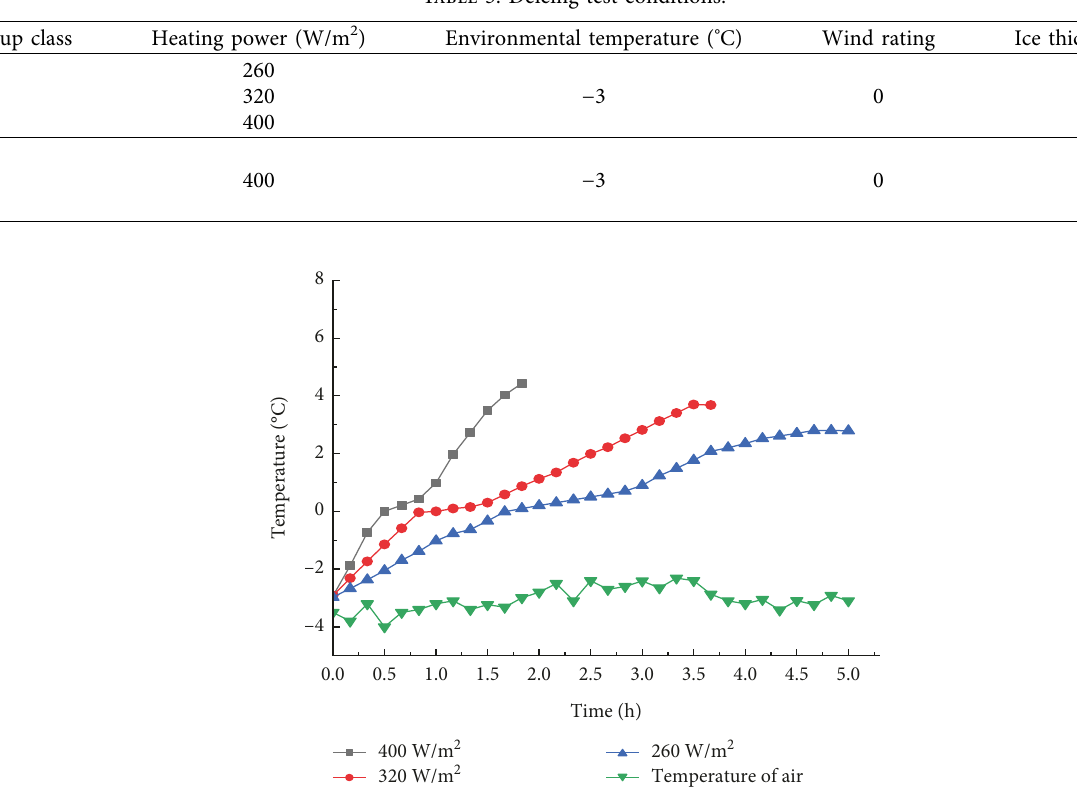
Figure 5: Curve of the surface temperature change of the test specimen under different powers.